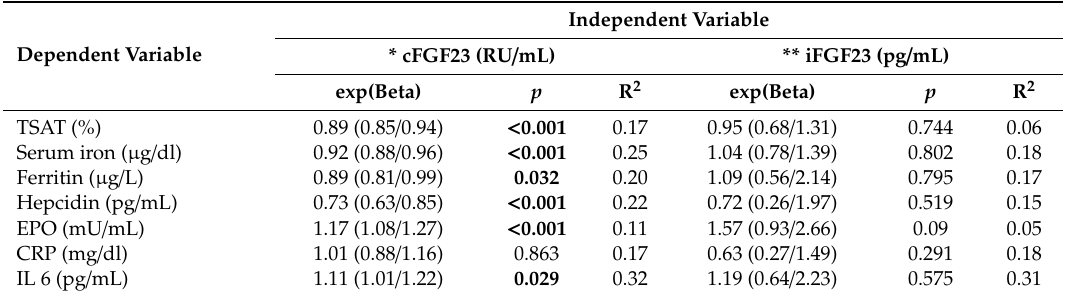
Table 4. Influence of cFGF23 and iFGF23 on biomarkers of iron metabolism, EPO concentrations and inflammation